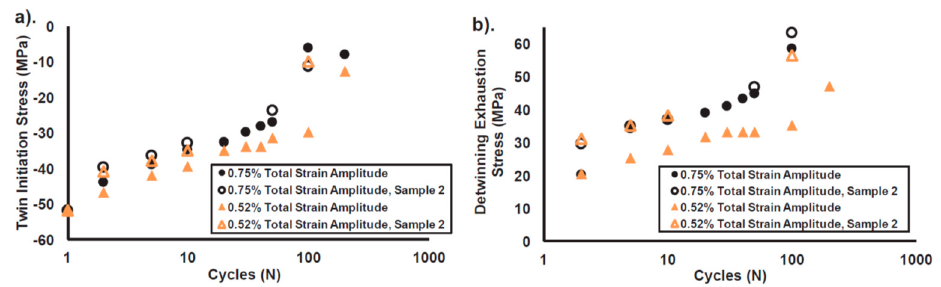
Figure 31. The variation of ( a ) twin initiation stress and ( b ) detwinning exhaustion stress versus the number of cycles in the case of cyclic loadings with the strain amplitude of 0.75% and 0.52% (After Murphy ‐ Leonard et al. [7]).